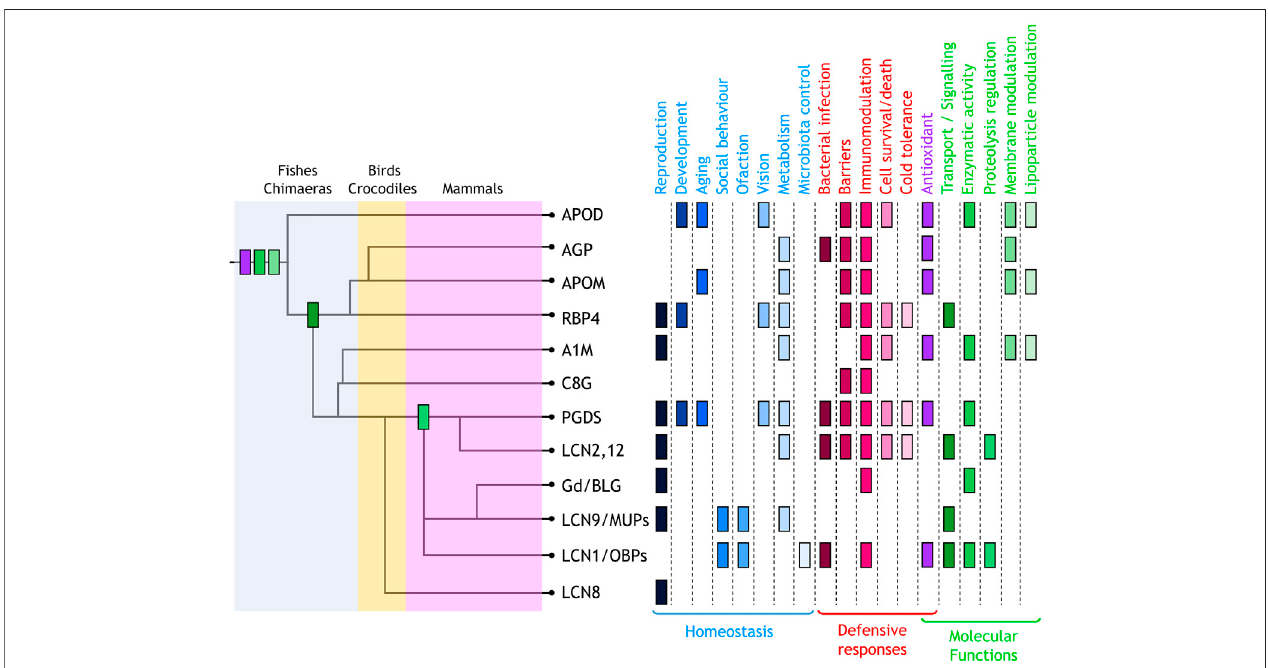
FIGURE 1 | Lipocalin functions mapped on the dendrogram of Lipocalin evolutionary history (Diez-Hermano et al.) where major monophyletic clades are shown. Physiologicalfunctionsidenti fi edareclassi fi edintohomeostatic(bluetones)anddefensive(redtones).Functionsde fi nedatthemolecular level(greentones)alsoinclude antioxidant(purple). The fi rst appearance ofthese molecular functionsintheevolutionarypath ofchordateLipocalinareindicatedinthetreeusing thesamecolourcode. Antioxidant, enzymatic activity, and membrane modulation are ancestral functions. The current knowledge places transport/signalling at the divergence of RBP4 and PGDS-related radiation. In contrast, proteolysis regulation appeared later in